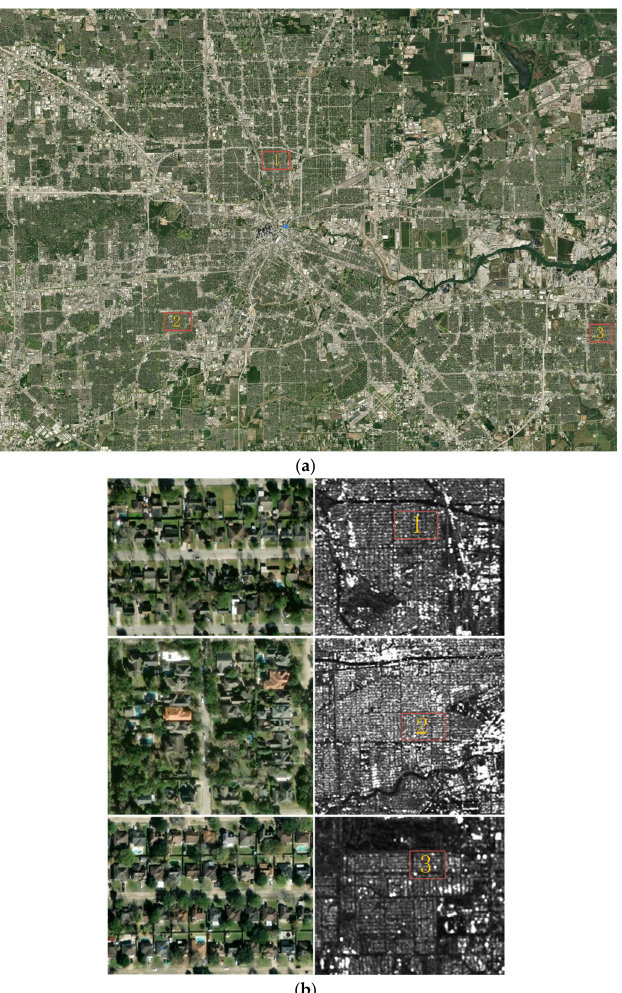
Figure 1. Optical-image and SAR-image displays of residential areas in the Houston area. ( a ) The Google optical image of the Houston area and the distribution of three specific residential clusters within the urban area. ( b ) The optical-image and SAR-image details of the slices of three residential areas. On the right is the scattering intensity of GRD (ground range detected) data of Sentinel-1B with a resolution of about 20 m, corresponding to the residential area.